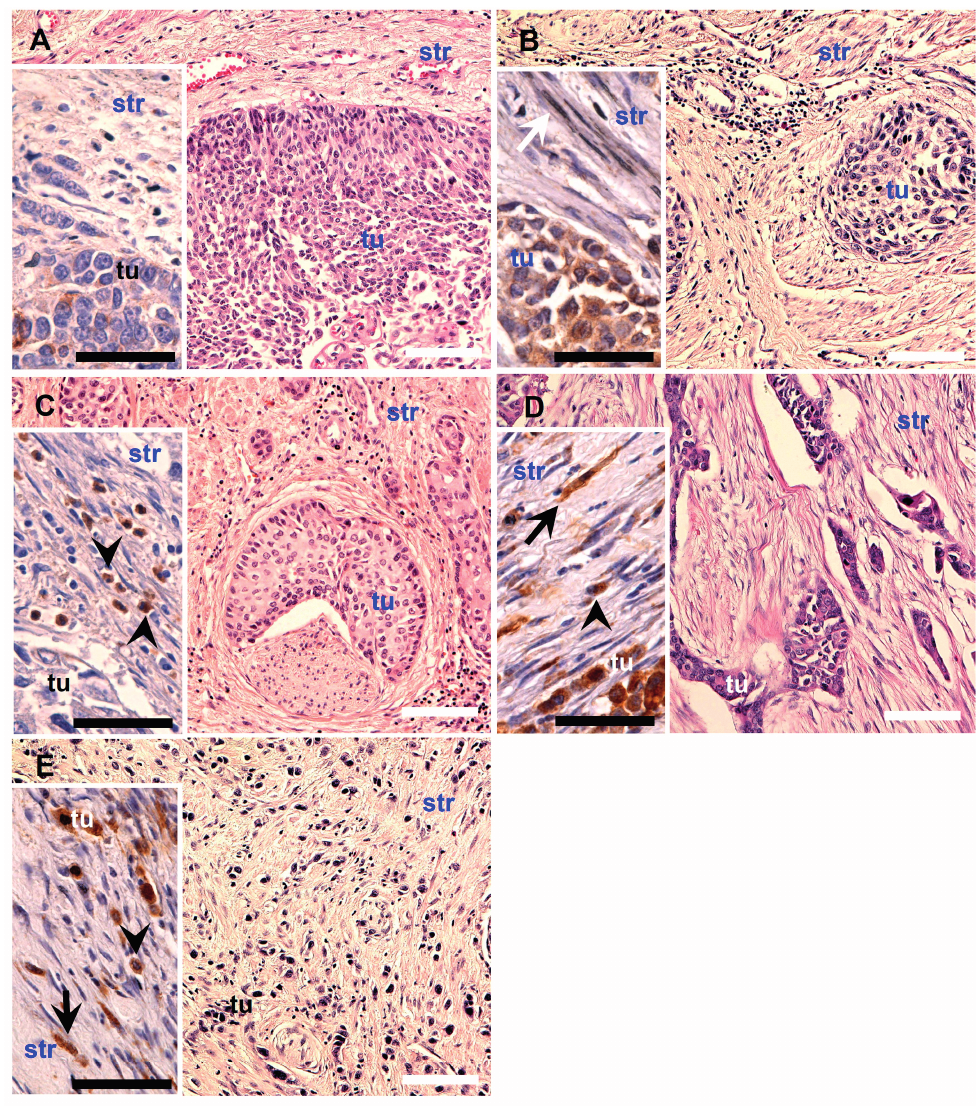
Figure 11. Types of invasion in sequence reflecting the increasing histological malignancy of the tumor: A -FR, B -FO, C -NE, D -ST, and E -DI type. Inserts represents RCAS1 immunostaining in stromal cells: arrows indicate fibroblasts, arrow heads–macrophages. White scale bars: 100 µm, black scale bars: 50